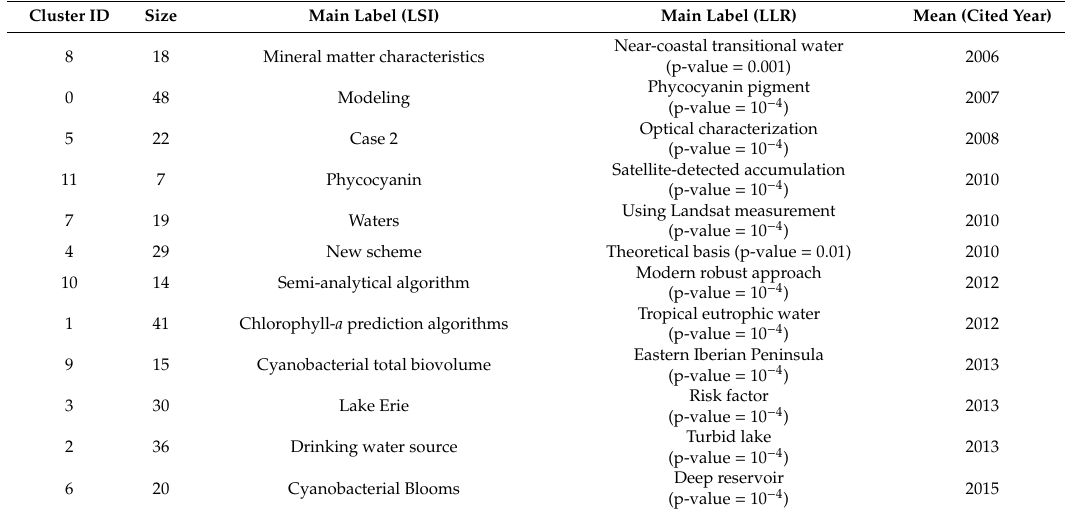
Table 5. Cluster labels of remotely sensed phycocyanin research over 30 years